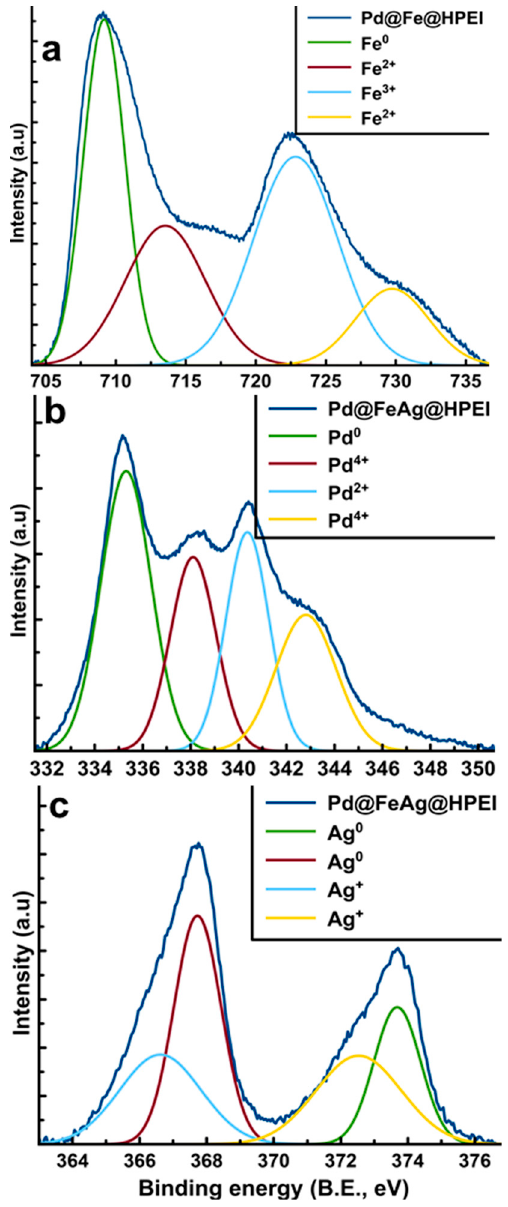
Figure 3. Deconvoluted XPS spectra of the prepared HPEI-stabilized nanoparticles: ( a ) Fe species